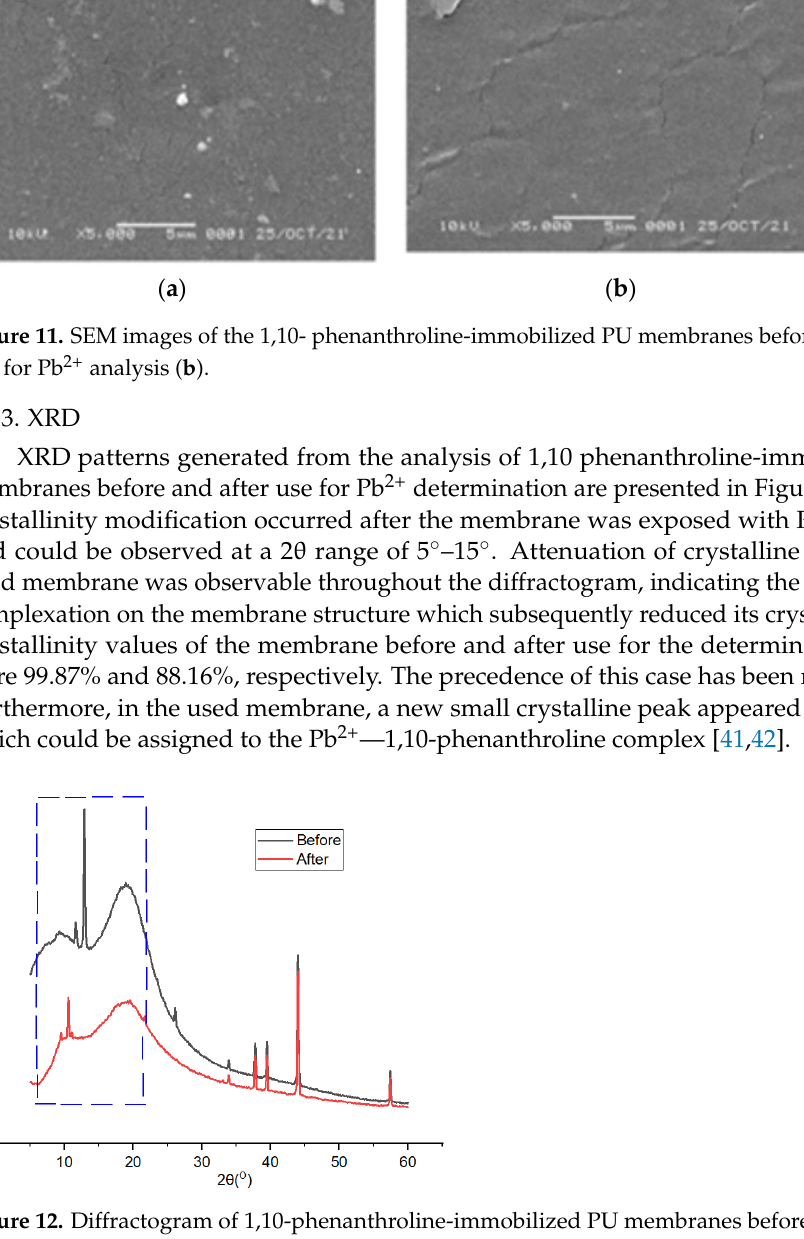
Figure 10. FT-IR spectra of 1,10 ‒ phenanthroline ‒ immobilized PU membranes before and after use for Pb 2+ analysis.